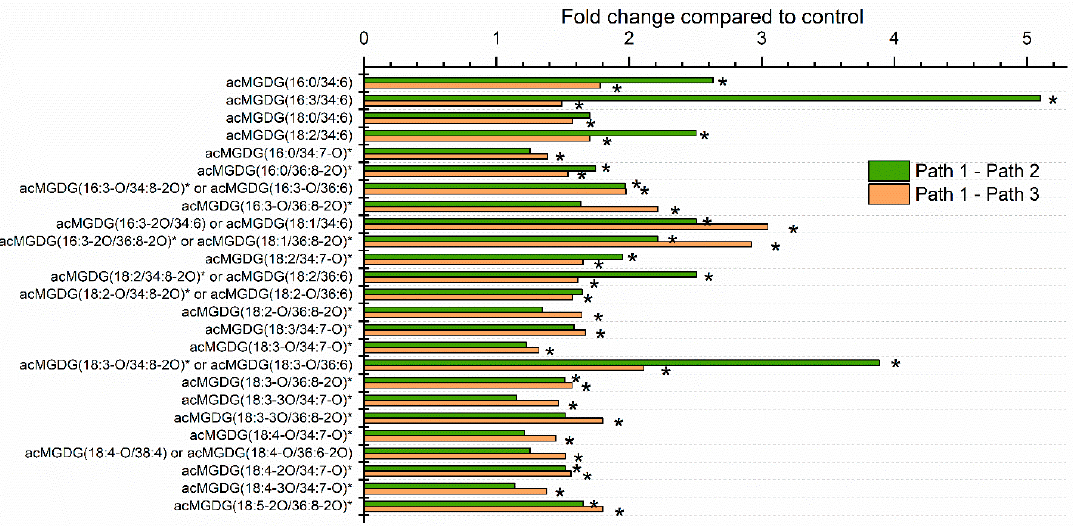
Figure 3. Leaf acylated monogalactosyldiacylglycerols, significantly altered by heat treatment. Values represent the level of each lipid under heat treatment over the level in control plants at 16 h after the start of the experiment. Control plants were maintained at 21 °C (Path 1), while Path 2 plants were subjected to 12 h at 38 °C plus 4 h at 45 °C, and Path 3 plants were subjected to 12 h at 21 °C plus 4 h at 45 °C. Lipid species with names ending in an asterisk are likely to contain oxophytodienoic acid (OPDA). A mixed effects ANOVA model was fitted to the data, and pairwise comparisons were made between paths; p -values of <0.05, after adjustment for FDR, were considered significant. The lipid species shown were those significantly altered in Path 2 and/or 3 compared to Path 1, as indicated by asterisks within the bar graph.